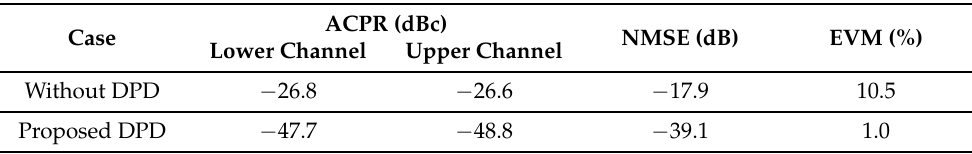
Figure 15. Comparison of the output spectra (solid line) and spectra of the error signals (dotted line) for the class J PA, without and with DPD. Input signal: 20 MHz 5G-NR. Average output level: 33.4 dBm. Table 2. Linearization performance of the proposed DPD technique for the PA near saturation. P out = + 33.4 dBm, 5G-NR 20